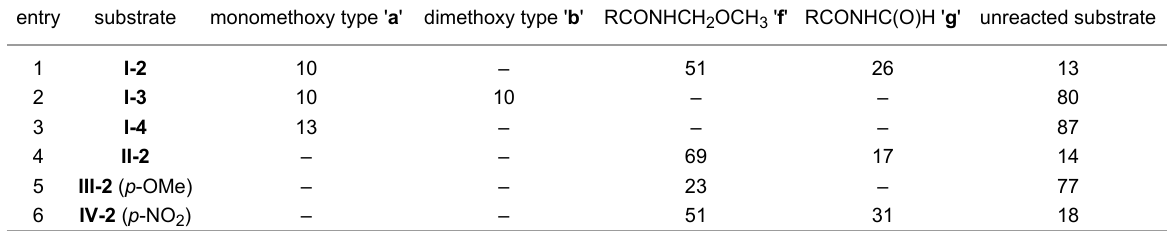
Table 4: Results of preparative electrolysis of selected bisamides in MeOH/Et 4 NBF 4 (at C rod anode, 10F, 20 mA/cm 2 ) a .